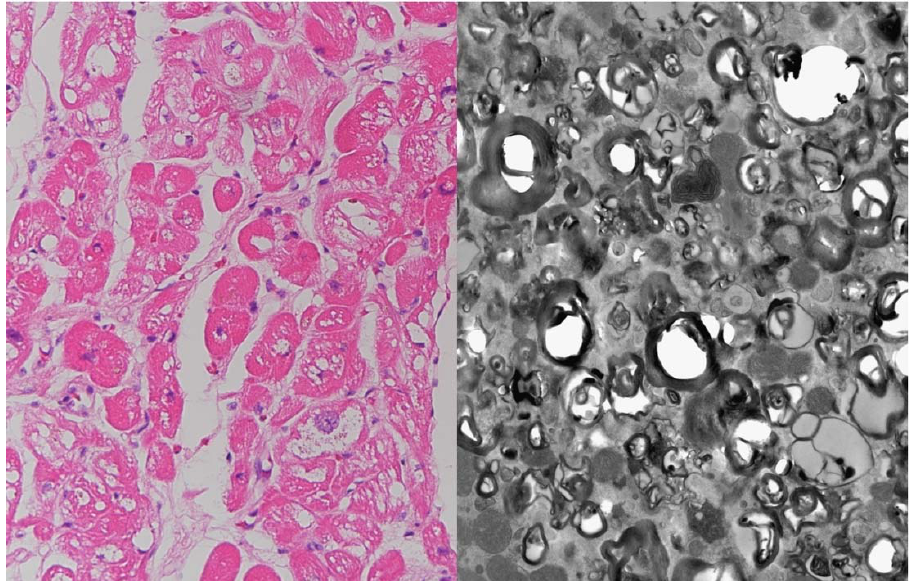
Figure 2. Endomyocardial biopsy specimen. Hematoxylin-eosin staining ( × 200) shows hyper- trophic myocytes with vacuolization ( left panel ). Electron microscopy shows dense lamellar bodies consistent with cardiac involvement of FD ( right panel ).